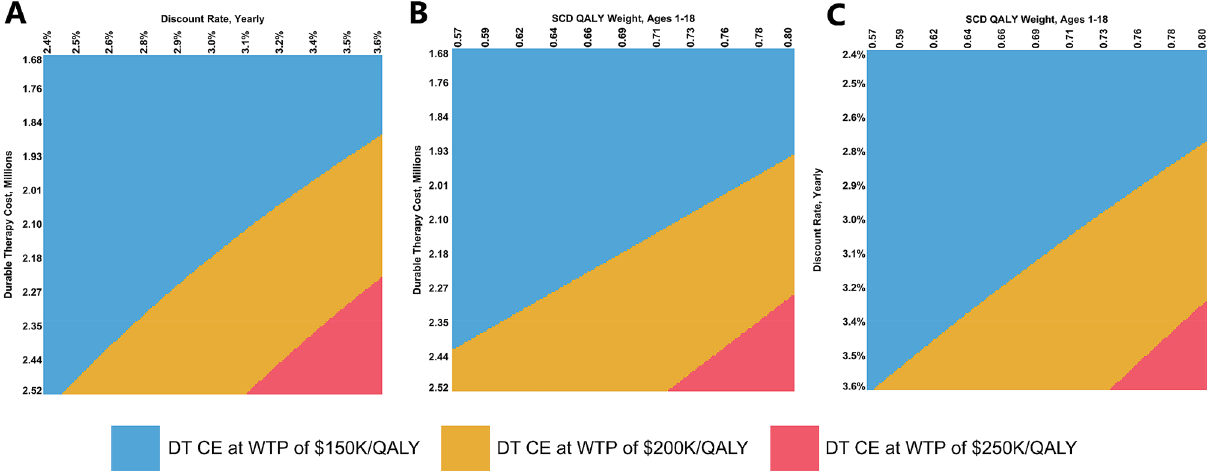
Figure 4. Two-way deterministic sensitivity analyses of select model parameters. ( A ) DT upfront cost versus yearly discount rate. ( B ) DT upfront cost versus pediatric QALY weight. ( C ) Yearly discount rate versus pediatric QALY weight. Parameters were varied simultaneously within their 95% CIs, or ± 20% when unavailable. DT , durable therapy; QALY , quality-adjusted life year; CI , confidence interval; CE , cost-effective; WTP , willingness to pay; K ,